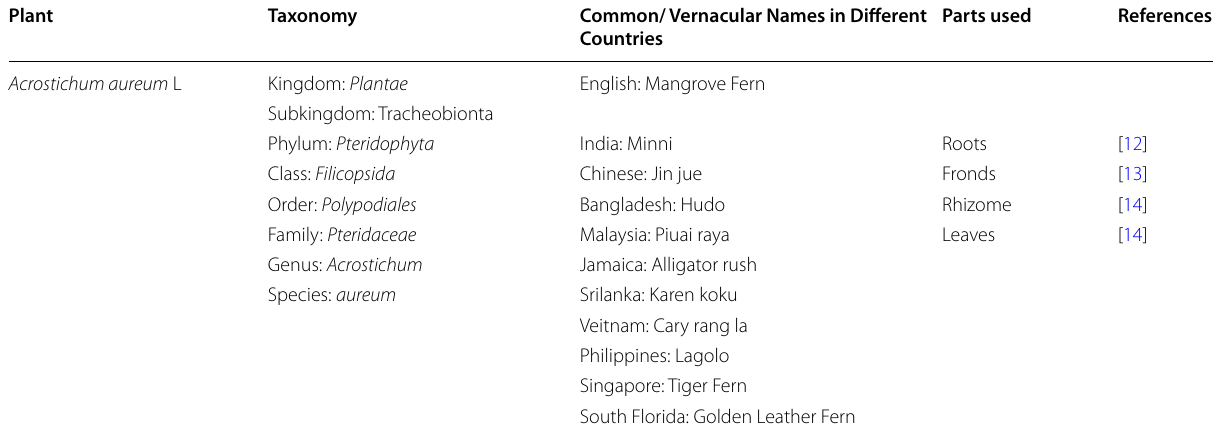
Table 1 General information on Acrostichum aureum